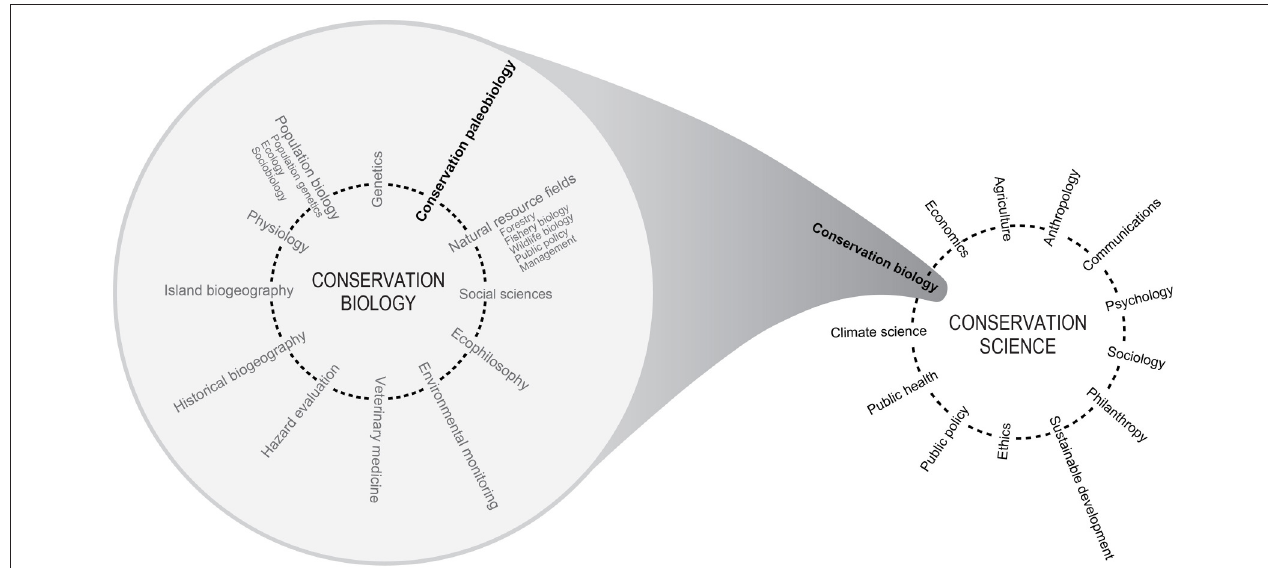
FIGURE 1 | The expanding domain of conservation science. The left diagram illustrates the contribution of conservation paleobiology to Soule’s (1985) synthetic, cross-disciplinary conservation biology. The diagram on the right depicts how Soule’s conservation biology fits into Kareiva and Marvier’s (2012) broader view of conservation science. Adapted from Peter Kareiva and Michelle Marvier, What Is Conservation Science? BioScience (2012) 62(11):962–969, by permission of the American Institute of Biological